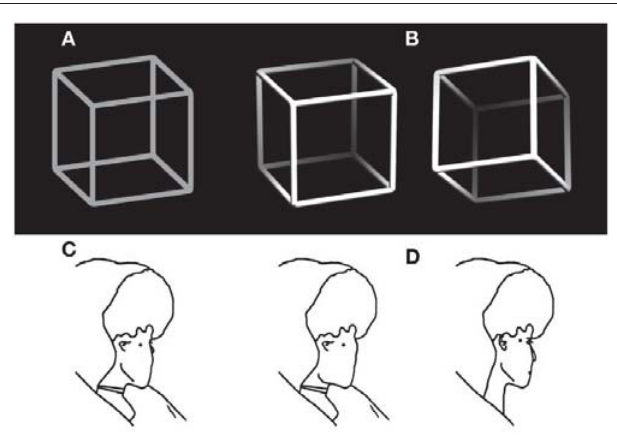
FIGURE 1 | Examples of ambiguous figures and their disambiguated variants. (A) The Necker cube (Necker, 1832) and (B) disambiguated versions with depth cues and a lightning model. (C) Outline version of Borings Old/Young woman figure (Boring, 1930) adapted from Gale and Findlay (1983) and (D) disambiguated old (left) and young woman figure